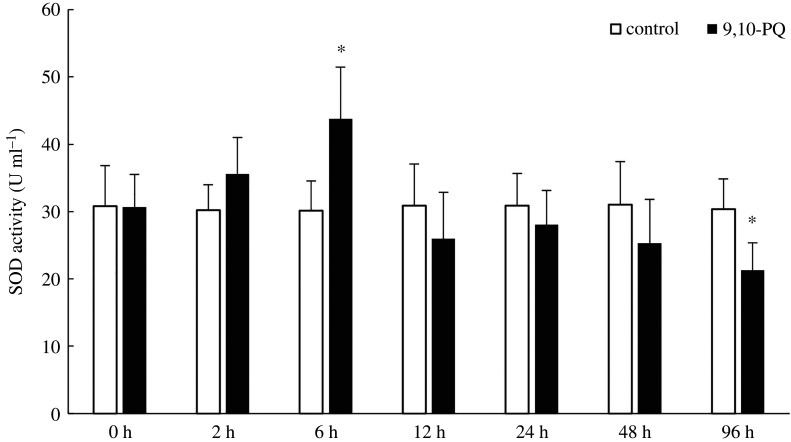
SOD activity in plasma of T. obscurus under sublethal exposure to 9,10-PQ. The data indicate mean (nine fish samples from three aquaria) and s.d. Significant differences (p < 0.05) between control and 9,10-PQ treatment are marked by asterisks (Student's t-test).